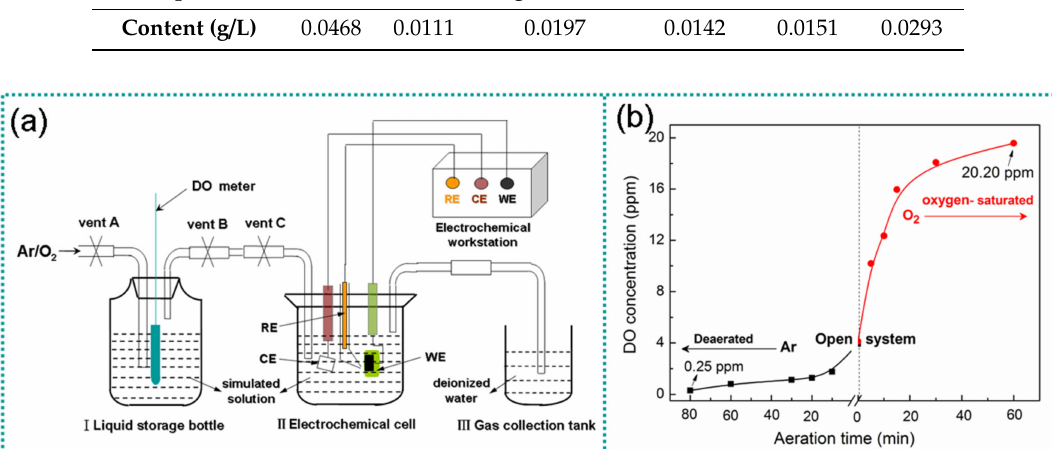
Figure 1. Schematic diagram of aerating device ( a ) and the oxygen content of the acidic soil simulated solution ( b